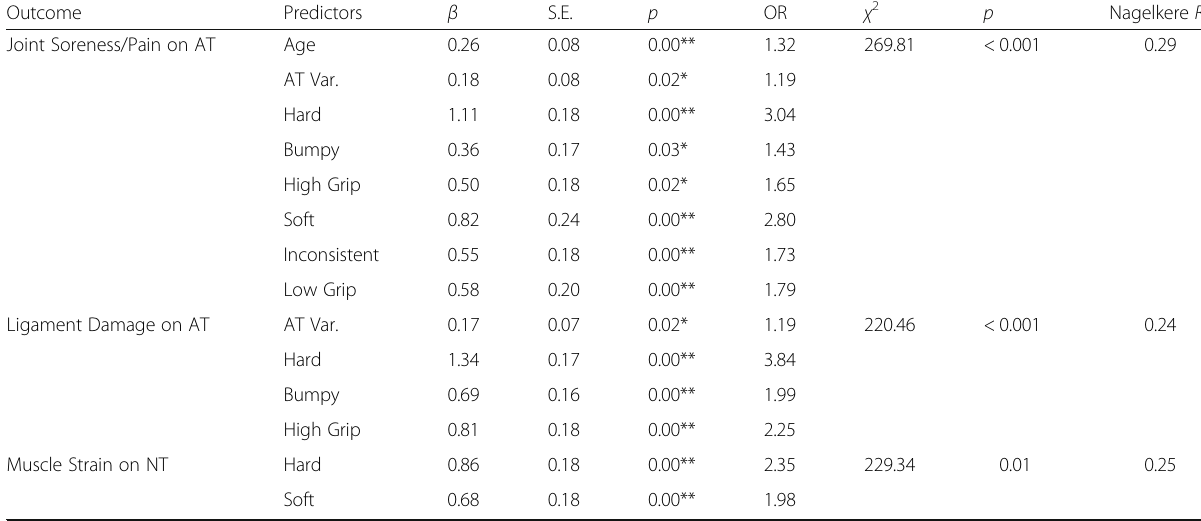
Table 3 Summary of binary logistic regression models for (i) Joint Soreness/Pain and AT, (ii) Ligament Damage and AT and (iii) Muscle Strain and NT Outcome